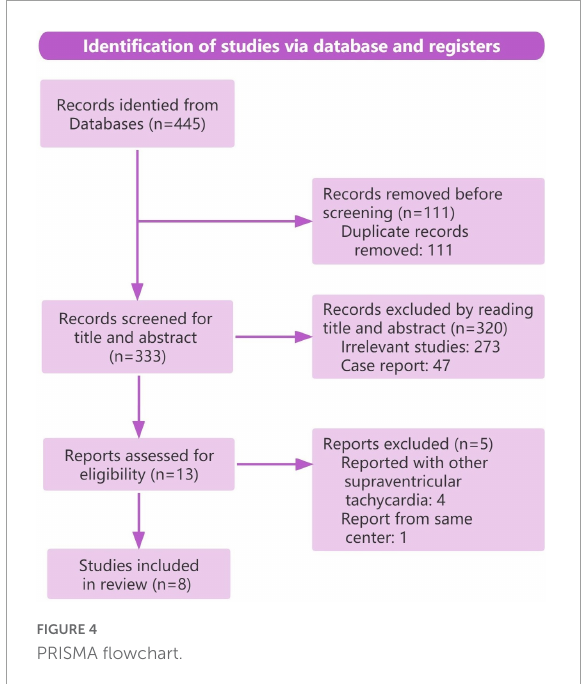
FIGURE4 PRISMA flowchart.